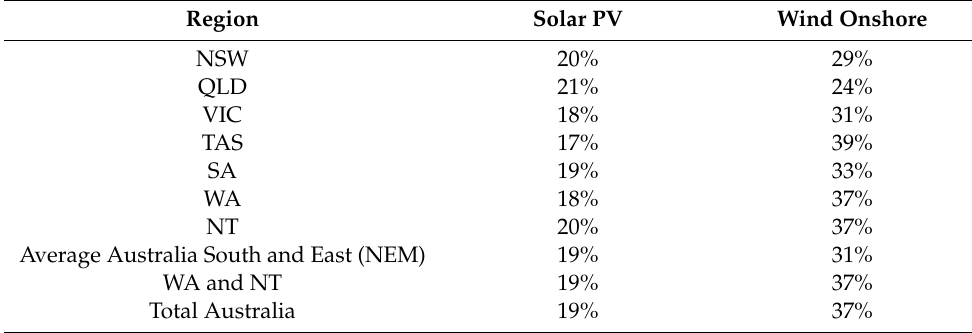
Table A12. VRE capacity factors. Data based on References [50,51].